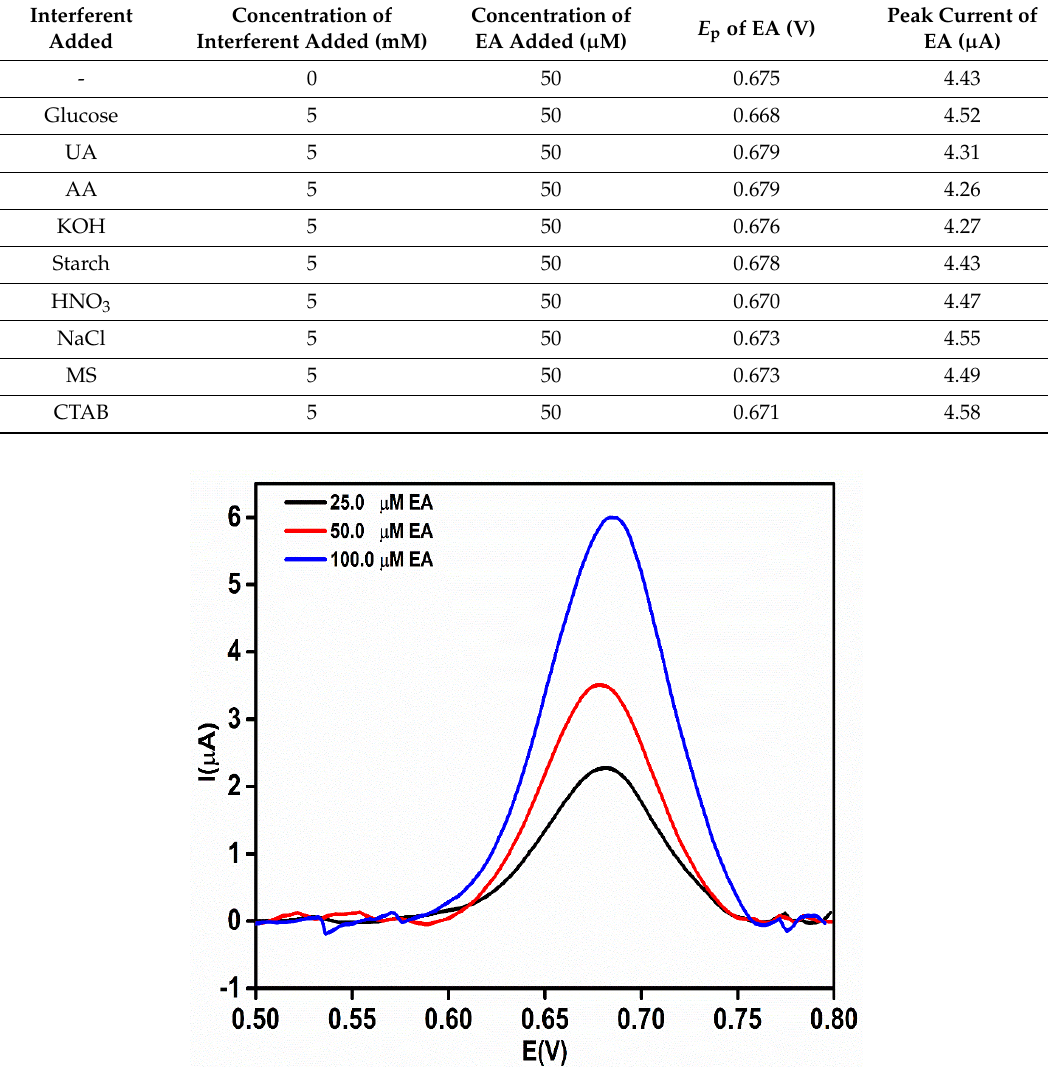
Table 2. Interference study results in the electrochemical detection of EA.